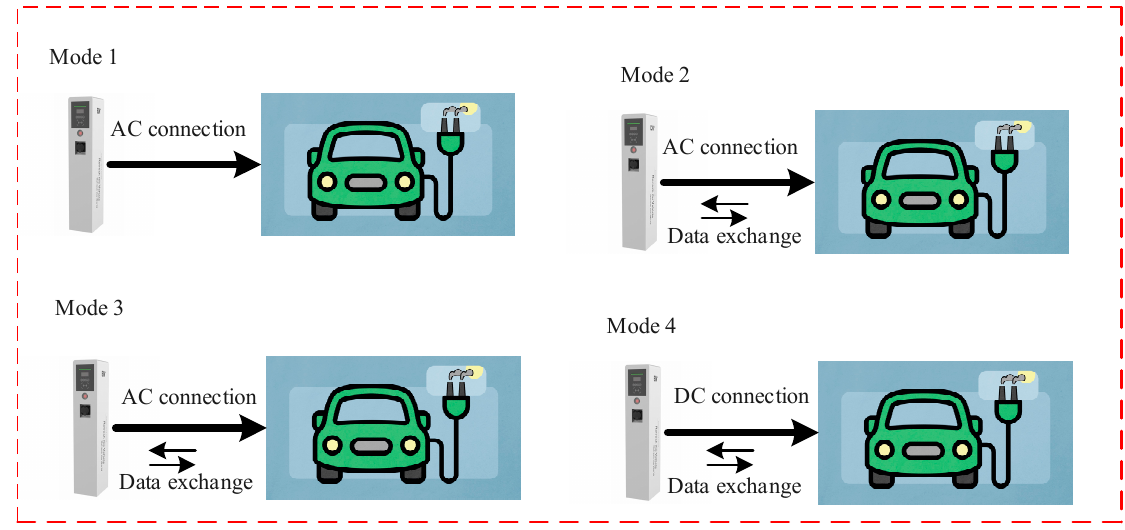
Figure 17. The various charging modes for EV applications.